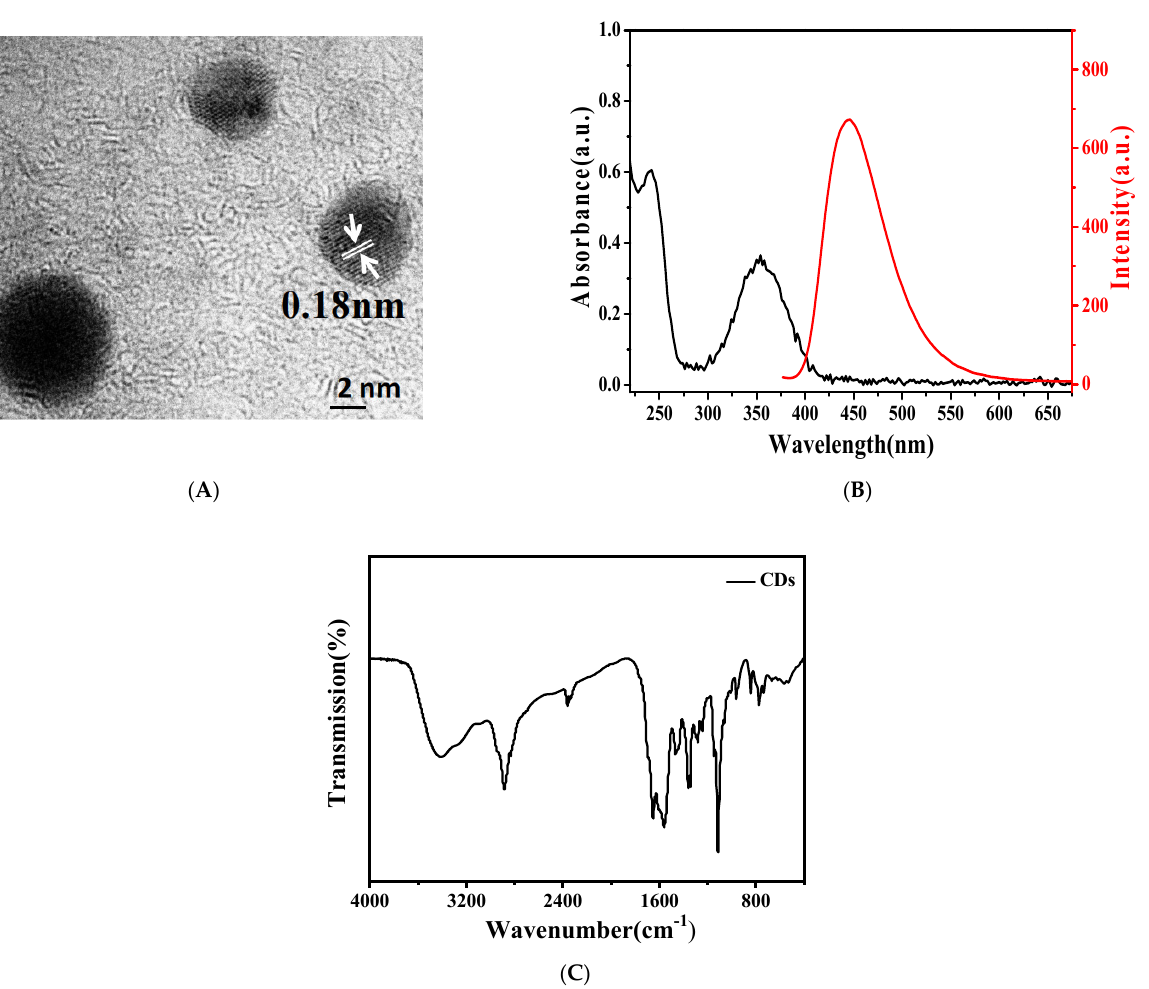
Figure 1. ( A ) Transmission electron microscopy (TEM) image, ( B ) UV-Vis absorption spectrum and fluorescence spectrum, and ( C ) Fourier transform infrared spectrum (FTIR) of carbon dots